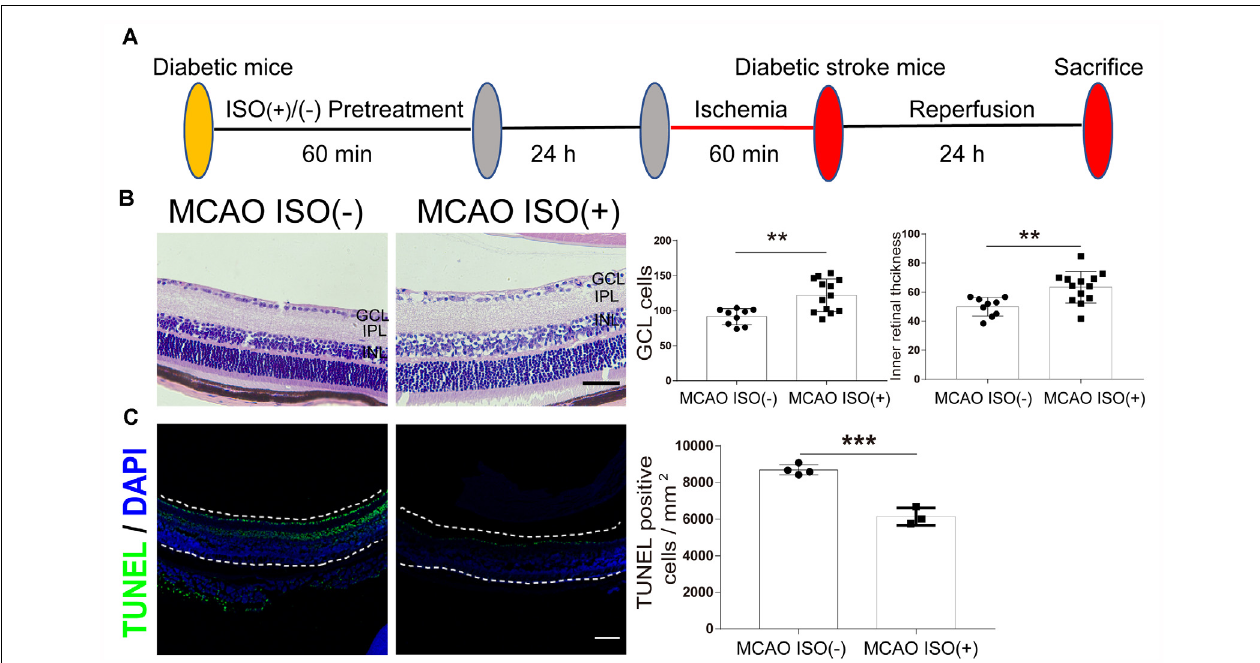
FIGURE 3 | ISO pretreatment reduces retinal injury after ischemic stroke in diabetic mice. (A) Diagram of ISO pretreatment protocol. (B) Left, representative H&E staining in the retina after MCAO with ISO pretreatment or without ISO pretreatment (magnification, 400 × ; scale bar, 50 µ m). Right, bar graphs showing the GCL cell count and the inner retinal thickness in the MCAO ISO ( − ) group ( n = 9) and MCAO ISO (+) groups ( n = 13). (C) Left, representative images showing TUNEL staining in the retina after MCAO with ISO pretreatment or without ISO pretreatment. The retina is indicated between the dotted lines. Green, TUNEL positive cell; Blue, DAPI (magnification, 100 × ; scale bar, 100 µ m). Scale bar, 100 µ m. Right, bar graphs showing the TUNEL positive cells density at GCL in the MCAO ISO ( − ) group ( n = 4) and MCAO ISO (+) groups ( n = 3). GCL, ganglion cell layer; IPL, inner plexiform layer; INL, inner nuclear layer. ** P < 0.01, *** P <